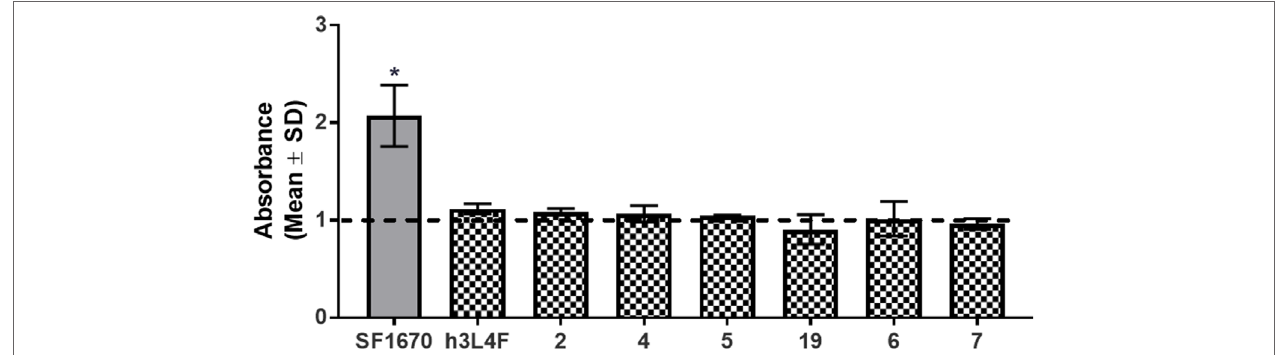
FIGURE 7 | Effects of peptide 1 derivatives on PTEN lipid phosphatase activity. Absorbance is inversely correlated to amount of PIP 2 generated in reaction of PTEN and PIP 3 in the absence of (dashed line) or presence (checkered bars) of peptide derivatives (10 μ M). Thus, elevated absorbance indicates reduced PTEN lipid phosphatase activity. PTEN inhibitor, SF1670 (200 µM; gray bar) is included as a positive control. The bars represent mean absorbance fold change over PTEN + PIP3 alone (± SD) of two independent experiments run in triplicate. * p < 0.05 vs. PTEN + PIP 3 alone (dashed line).